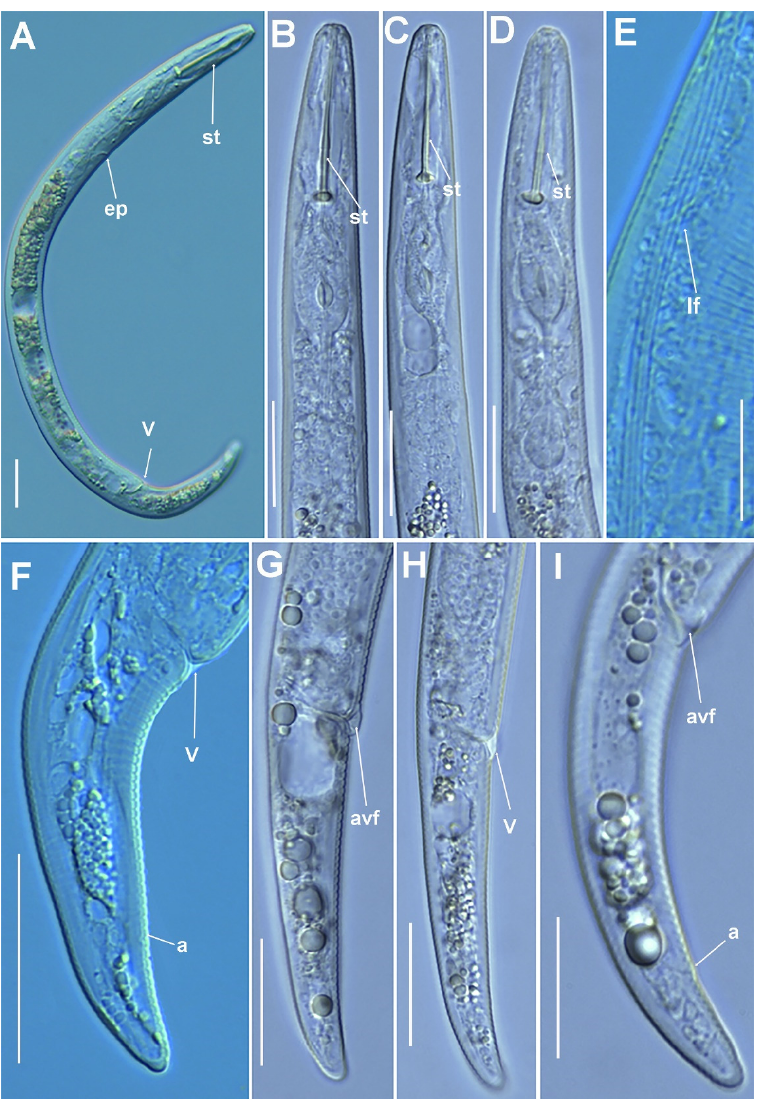
Figure 11. Micro-photomicrographs of Paratylenchus salubris Raski, 1975 female. ( A ) Whole female with stylet, excretory pore and vulva arrowed; ( B–D ) Pharyngeal region; ( E ) Detail of lateral fields; ( F – I ) Female posterior region with vulva and anus (arrowed) and detail of vulva showing advulval flap (arrowed). Scale bars ( A – I = 20 μ m). (Abbreviations: a = anus; avf = advulval flap; ep = excretory pore; lf = lateral field; st = stylet; V = vulva).